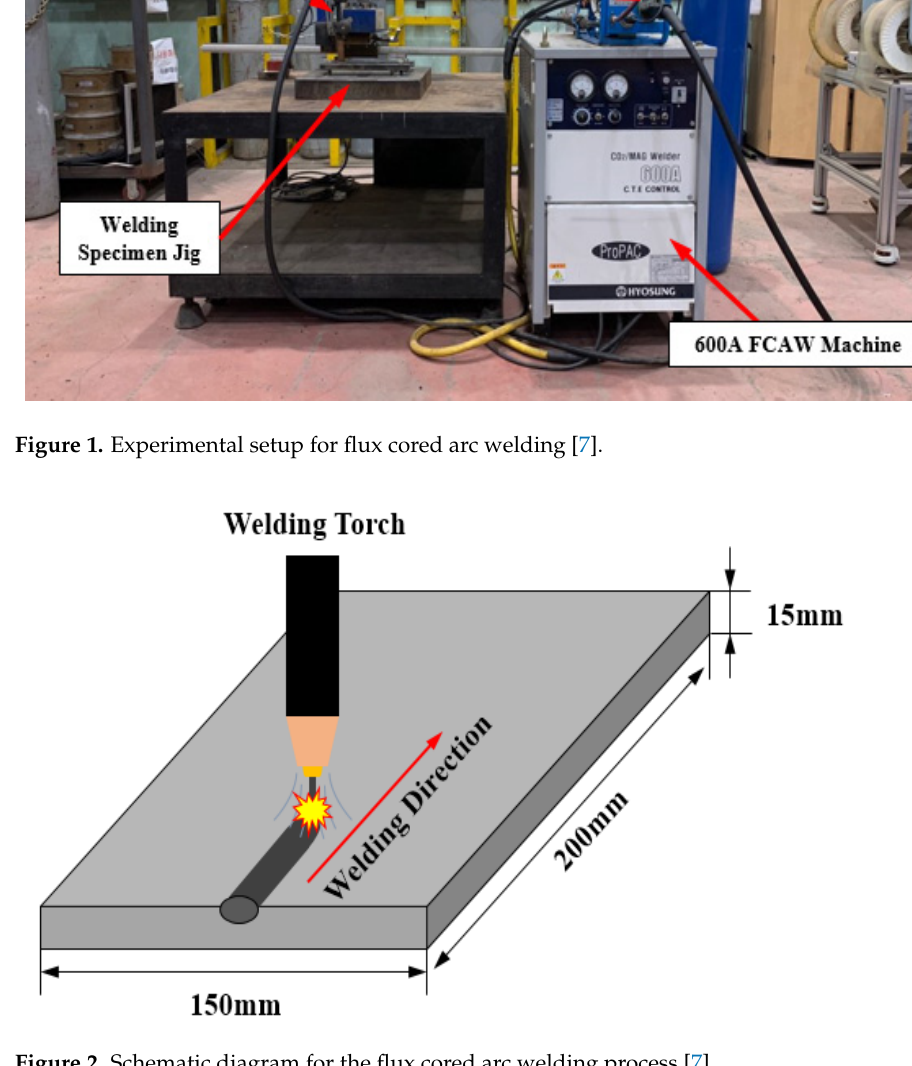
Figure 1. Experimental setup for flux cored arc welding [7].